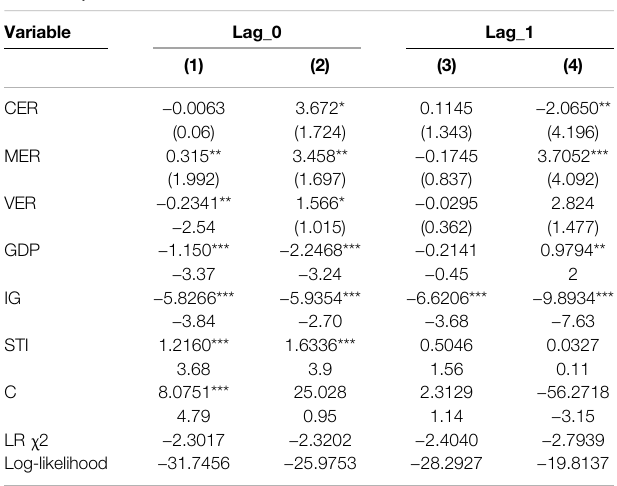
TABLE 8 | Robustness